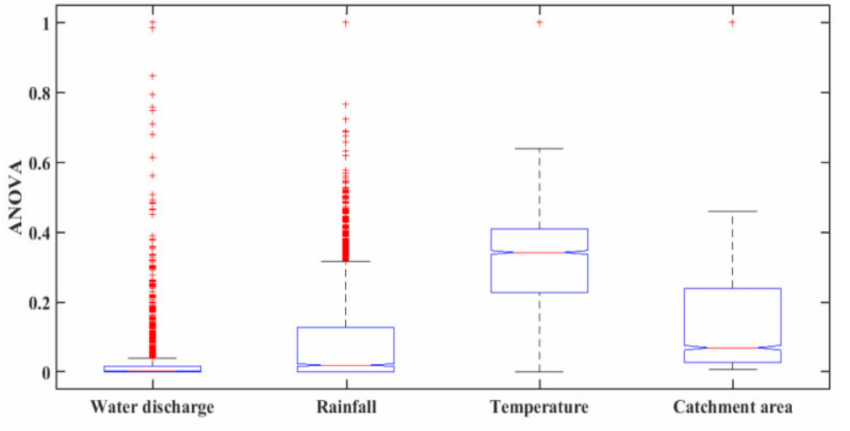
Figure 4. ANOVA test result of the input data. Table 3. Analysis of Variance (ANOVA) test results of the hydro climatical data